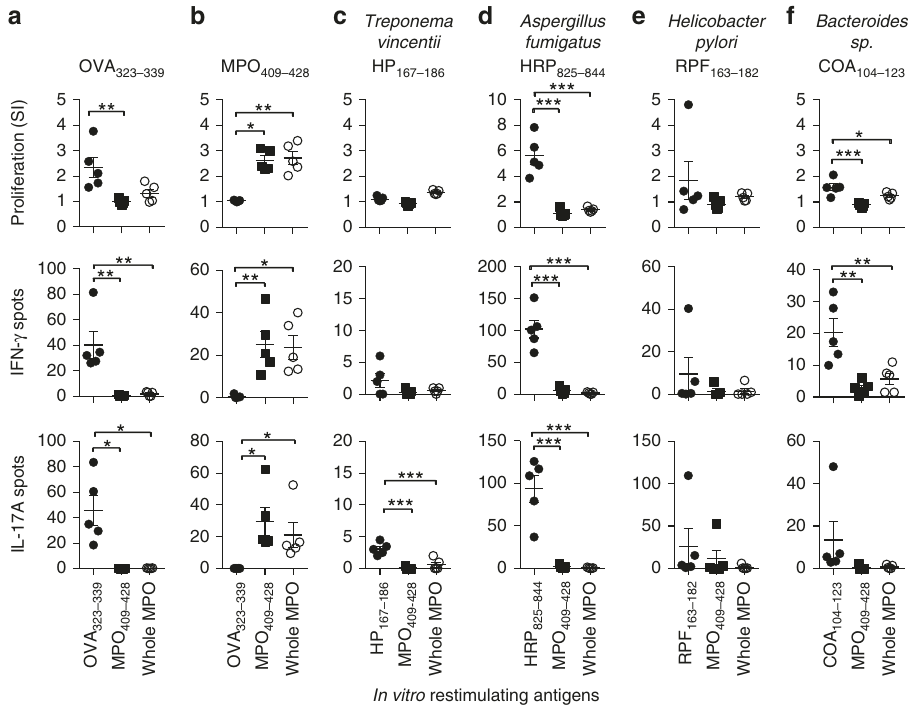
Fig. 1 Microbe-derived peptides with closest sequence homology to MPO 409 – 428 do not induce cross-reactivity to MPO. C57BL/6 mice ( n = 5 each group) were immunized with peptides, either a OVA 323 – 339 (negative control), b MPO 409 – 428 (positive control), c Treponema vincentii- derived hypothetical protein, HP 167 – 186 , d Aspergillus fumigatus- derived HEAT repeat protein, HRP 825 – 844 , e Helicobacter pylori- derived RNA polymerase factor sigma-54, RPF 163 – 182 , or f Bacteroides sp .-derived chloramphenicol O-acetyltransferase, COA 104 – 123 , then, T-cell recall responses measured ex vivo by restimulating draining lymph node cells with either the immunizing peptide, MPO 409 – 428 or recombinant mouse MPO (rmMPO) by [ 3 H]-thymidine proliferation assays (top row), and ELISPOT for IFN- γ (middle row) or IL-17A (bottom row). Each dot represents the response from one mouse, error bars are the mean ± s.e.m. Data are representative of two independent experiments. * P < 0.05, ** P < 0.01, *** P < 0.001 by Kruskal – Wallis test. Source data are provided as a Source Data fi